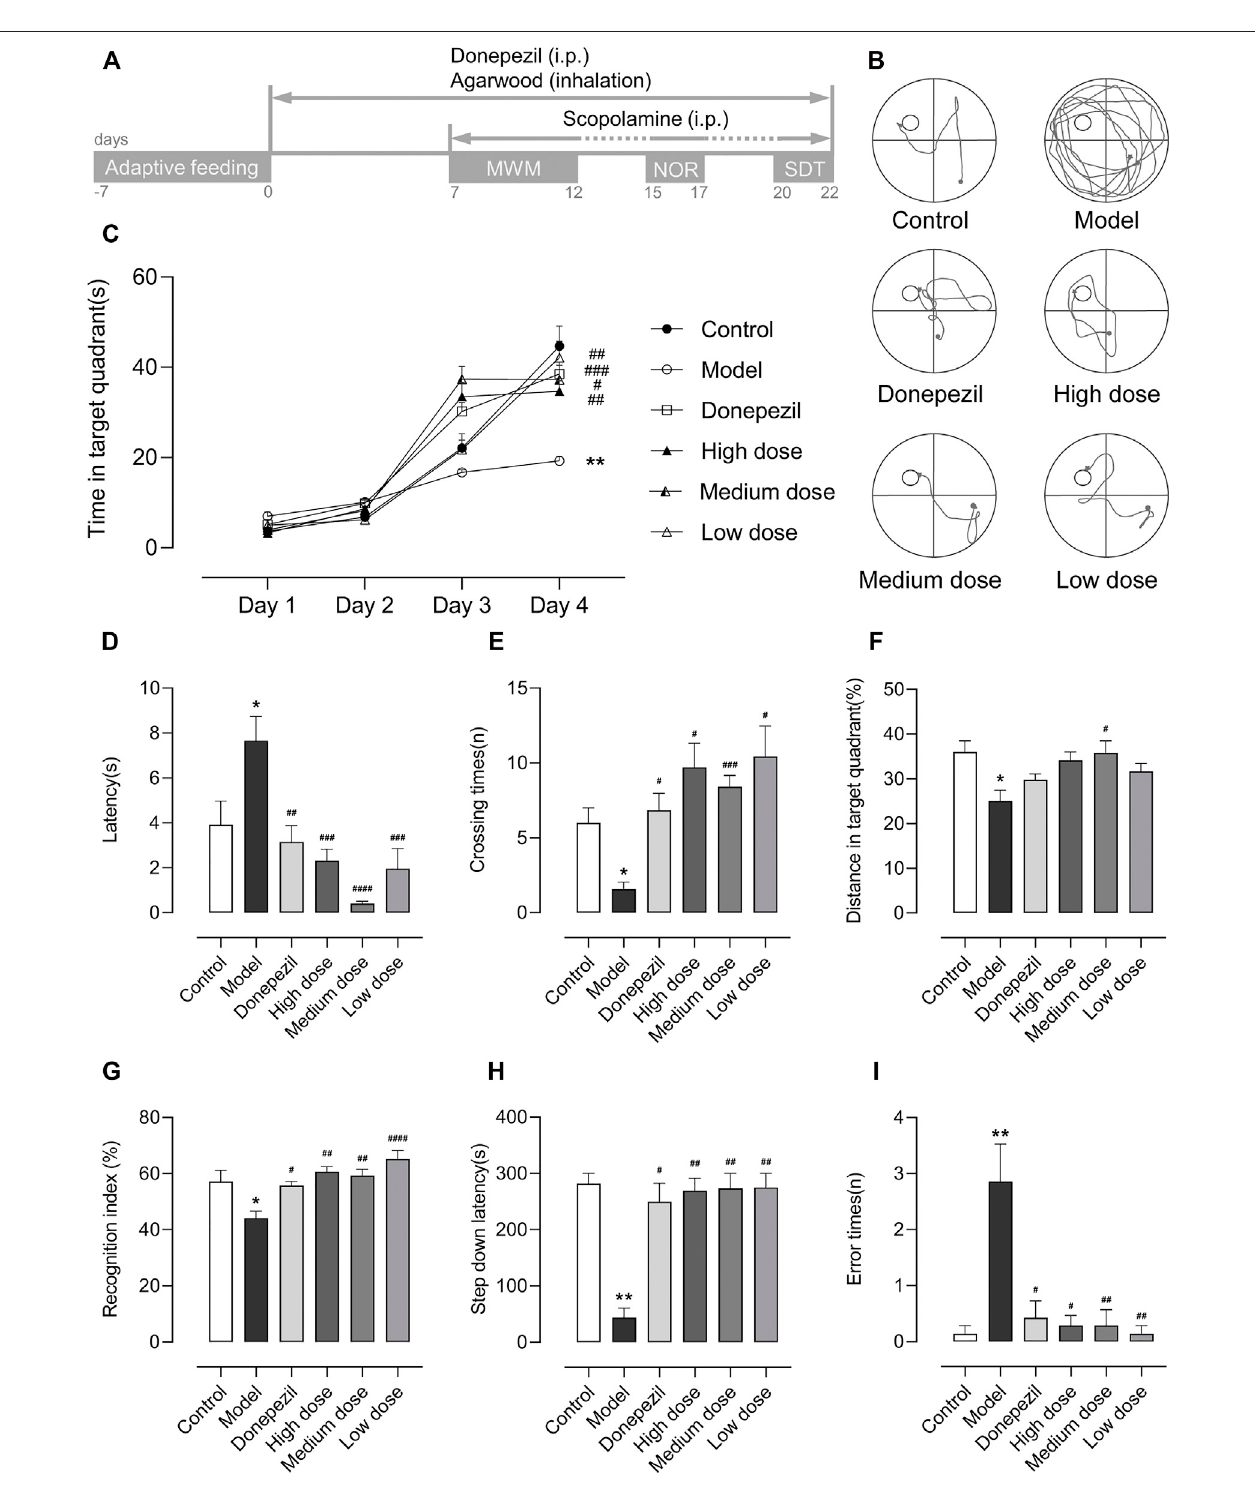
FIGURE 1| Schedule oftreatment and behavioraltests and the results of the MWM, NOR, and SDT ( n (cid:1) 7). Data are shown asmean ± standard error of the mean (SEM). (A) After 7 days of adaptive feeding, the mice received a 22-days treatment except for the control and model groups, and then scopolamine was injected intraperitoneally30 minbeforethestartofeachbehavioraltestexceptforthecontrolgroup.Betweeneachbehavioraltest,themiceweregiven3 daystorecoveranddid not need to be injected with scopolamine. (B) The trajectory on the fourth day of MWM. (C) The time in target quadrant for the fi rst 4 days of MWM. (On the fourth day: Model: p (cid:1) 0.008, Donepezil: p < 0.001, Agarwood high dose: p (cid:1) 0.006, Medium dose: p (cid:1) 0.023, Low dose: p (cid:1) 0.004). (D) The escape latency of MWM.